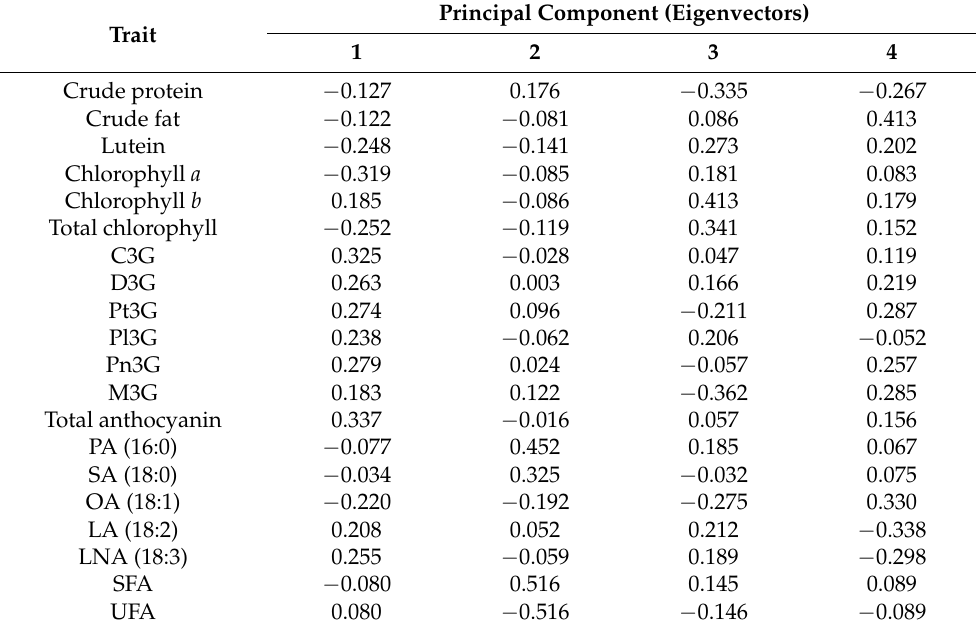
Table 4. The 4 principal components among 20 seed composition traits of 468 black soybean germplasms with green cotyledons, including check cultivars ‘Cheongja 3’ and ‘Cheongja’. Principal Component (Eigenvectors) Trait 1 2 3 4 Crude protein − 0.127 0.176 − 0.335 − 0.267 Crude fat − 0.122 − 0.081 0.086 0.413 Lutein − 0.248 − 0.141 0.273 0.202 Chlorophyll a − 0.319 − 0.085 0.181 0.083 Chlorophyll b 0.185 − 0.086 0.413 0.179 Total chlorophyll − 0.252 − 0.119 0.341 0.152 C3G 0.325 − 0.028 0.047 0.119 D3G 0.263 0.003 0.166 0.219 Pt3G 0.274 0.096